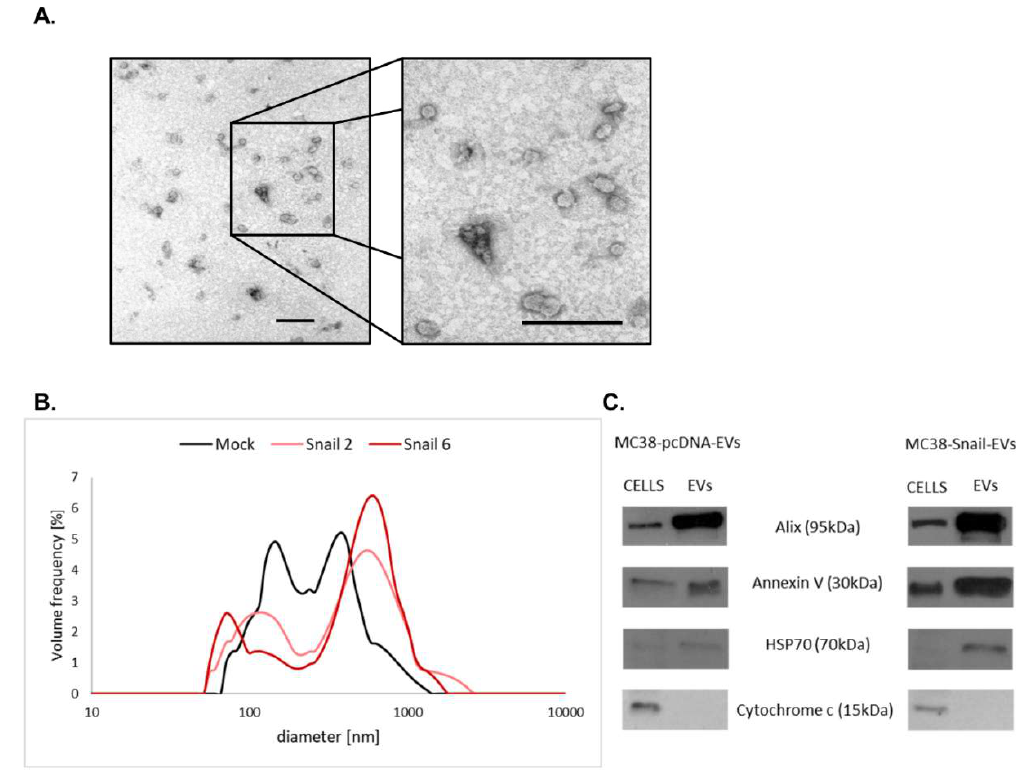
Figure 3. Characterization of pcDNA-MC38- and Snail-MC38-derived extracellular vesicles (EVs). ( A ) Representative electron microscopic images of EVs derived from Snail-MC38 cells (Scale bars: 200 nm). ( B ) Average size distribution of EVs measured by dynamic light scattering (DLS). ( C ) Representative Western blot analysis of EV markers expression in pcDNA- and Snail-MC38 cells and corresponding EVs. Immunoblotting demonstrates the enrichment of Alix and Annexin V, the presence of HSP70, and the absence of Cytochrome C in EVs compared with cell lysates. For both cells and EVs samples, the same amount of proteins per lane was loaded (10 µ g for Alix, Annexin V, and HSP70 and 20 µ g for Cytochrome c).